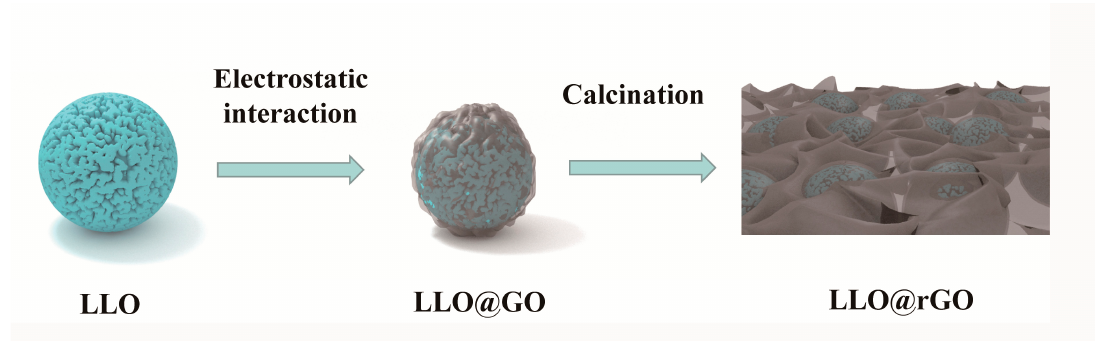
Figure 1. Schematic diagram of the preparation of modified LLO (LLO@rGO), where LLO is layered lithium-rich manganese oxide, and rGO is reduced graphene-oxide.